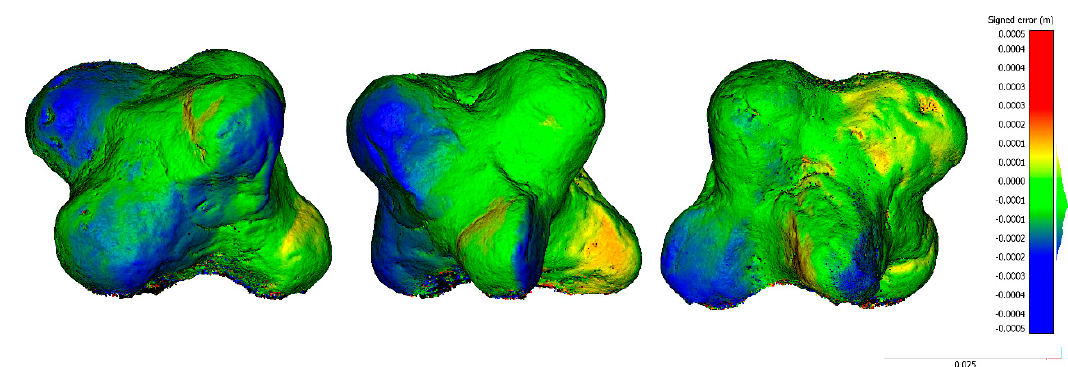
Figure 10. Different views of the spatial distribution of discrepancies between zoom lens reconstruction versus macro lenses for the specimen S1 (separator): front view ( left ); right side view ( center ); and back view ( right ).